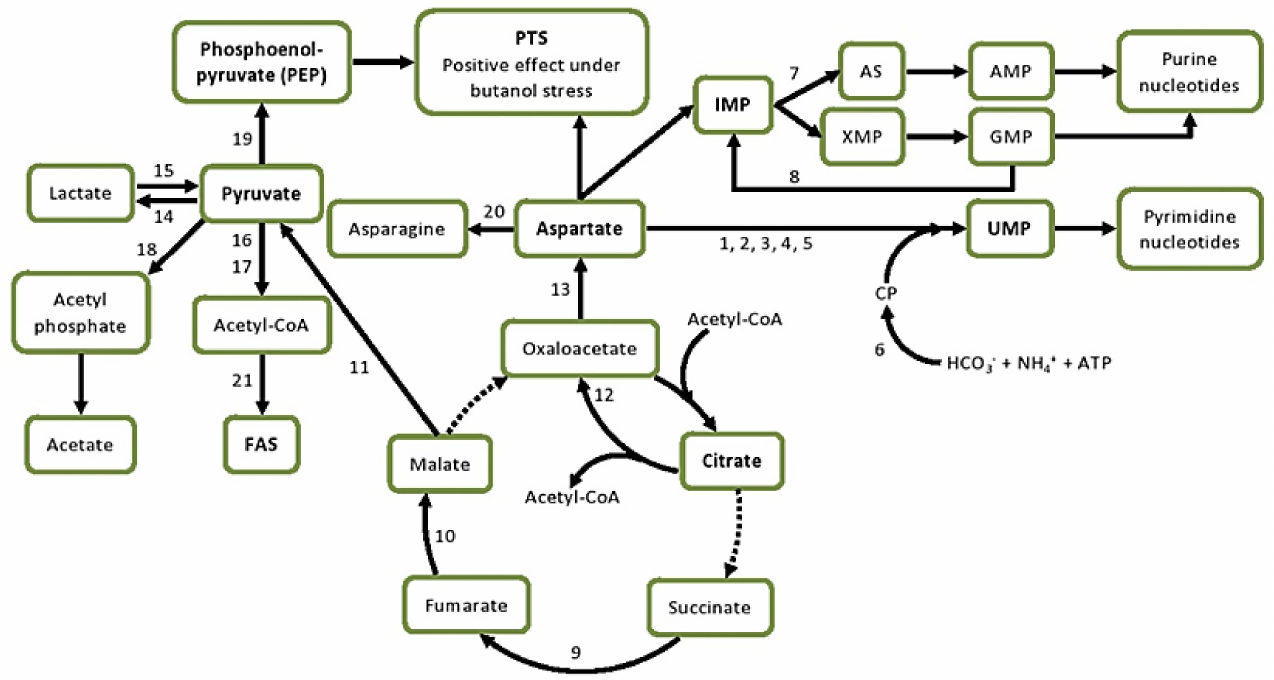
Figure 5. Metabolic redistribution of citrate, aspartate, and pyruvate under butanol stress in L. plantarum strains 8-1 and Ym1. Regulated enzymes as explained in the text: 1, aspartate carbamoyltransferase; 2, dihydroorotase; 3, dihydroorotate dehydrogenase; 4, orotate phosphoribosyltransferase; 5, orotidine-5’-phosphate decarboxylase; 6, carbamoyl phosphate synthase; 7, adenylosuccinate synthase; 8, guanosine monophosphate reductase; 9, succinate dehydrogenase; 10, fumarate hydratase; 11, NAD(P)-dependent malic enzyme; 12, citrate lyase; 13, aminotransferase; 14, L-lactate dehydrogenase; 15, L-lactate oxidase; 16, pyruvate dehydrogenase complex (PDHC); 17, pyruvate formate lyase; 18, pyruvate oxidase; 19, phosphoenolpyruvate synthase 20, asparagine synthase; 21, acetyl-CoA carboxylase. Abbreviations: AMP, adenosine monophosphate; AS, adenylosuccinate; ATP, adenosine triphosphate; FAS, fatty acid synthesis; GMP, guanosine monophos- phate; IMP, inosine monophosphate; PEP, phosphoenolpyruvate; PTS, PEP: carbohydrate phosphotransferase system; UMP, uridine monophosphate; XMP, xanthosine monophosphate. Continuous lines denote existing metabolic pathways; dotted lines denote metabolic pathways, which appear non-functional according to our transcriptomic data for both